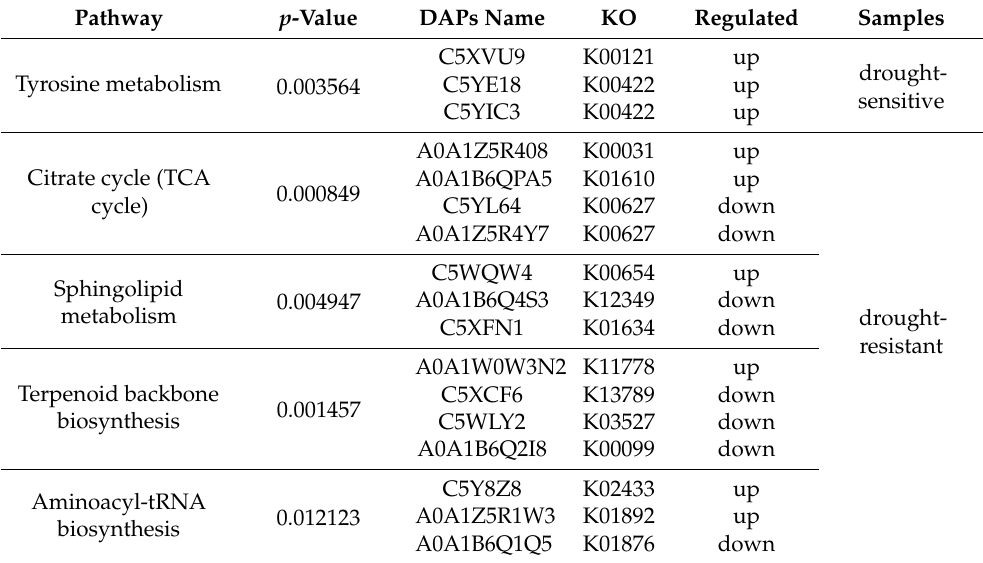
Table 1. Significant enrichment analysis of DAP pathways ( p -value < 0.05). Pathway p